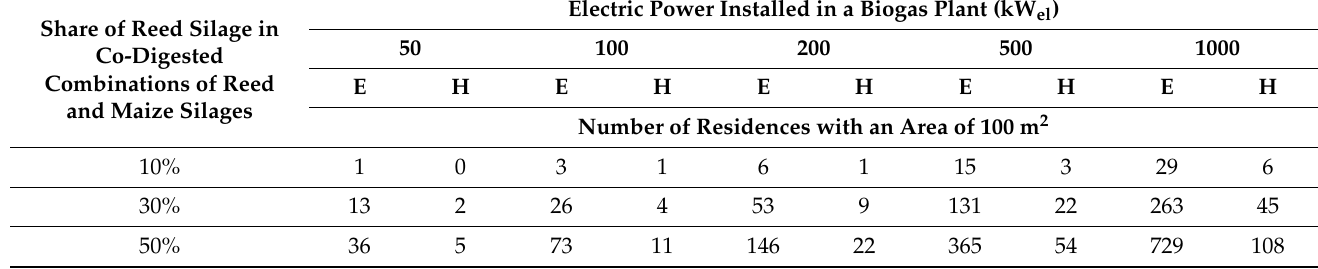
Table 10. The number of residences supplied with energy generated only from RS used as co-substrate depending on the size of a biogas